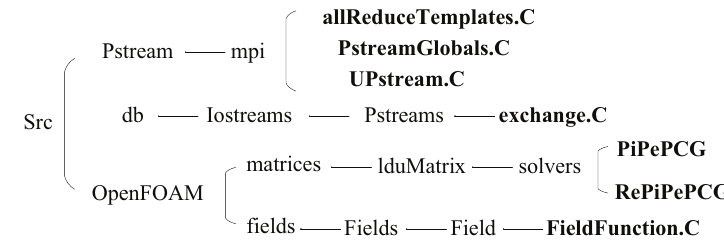
Figure 7. Structure of modified files.